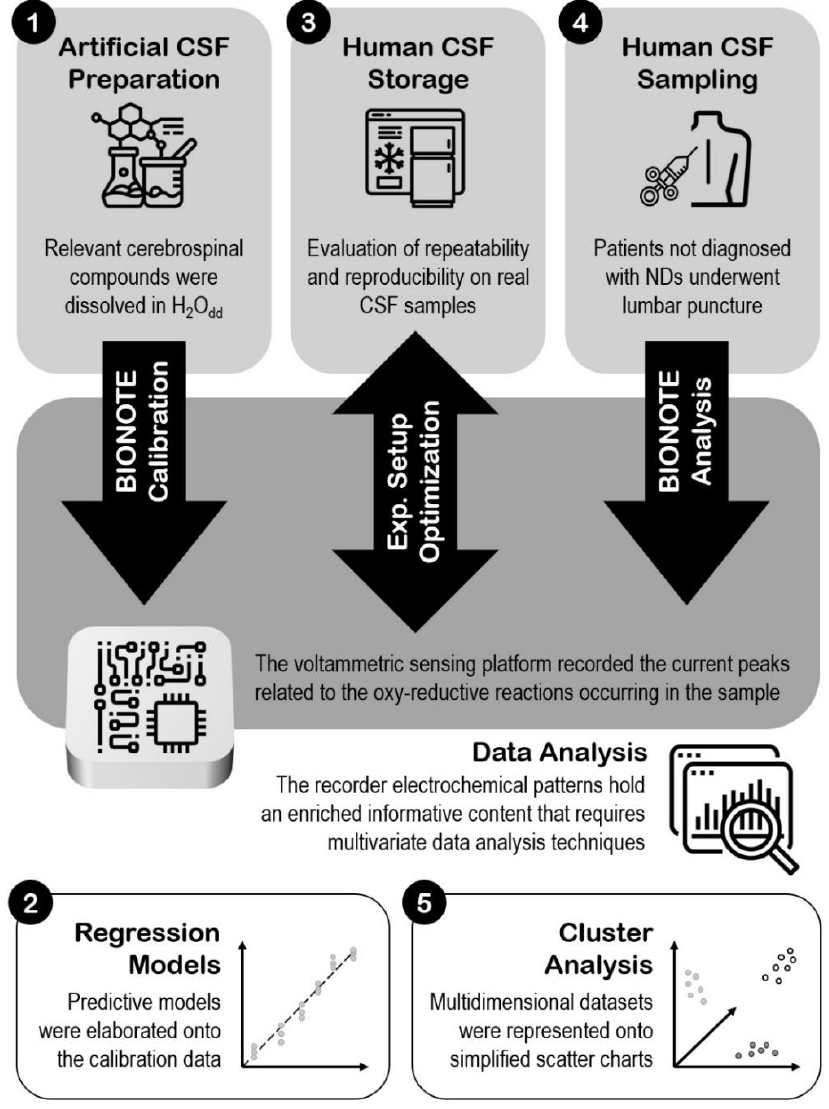
Figure 1. Experimental set-up.